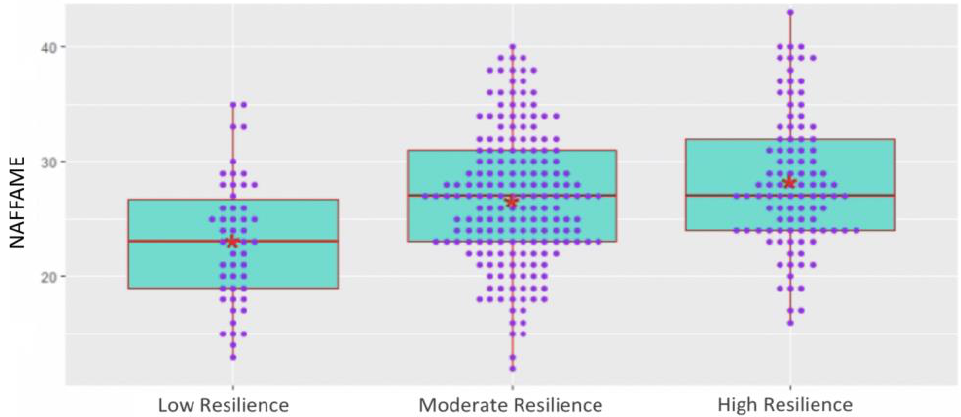
Figure 1. One-way ANOVA test showing the difference between NAFFAME scores in different PsyR categories.